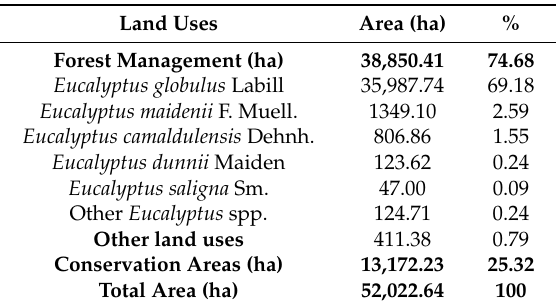
Figure 1. Location of Ence’s forest management units (FMUs) in the province of Huelva. Table 1. Summary of Ence’s forest management units in the province of Huelva, including the total area of each eucalyptus species, other land uses (infrastructure, reservoirs, paths, firewalls, etc.) and conservation areas. Total surface expressed in bold.